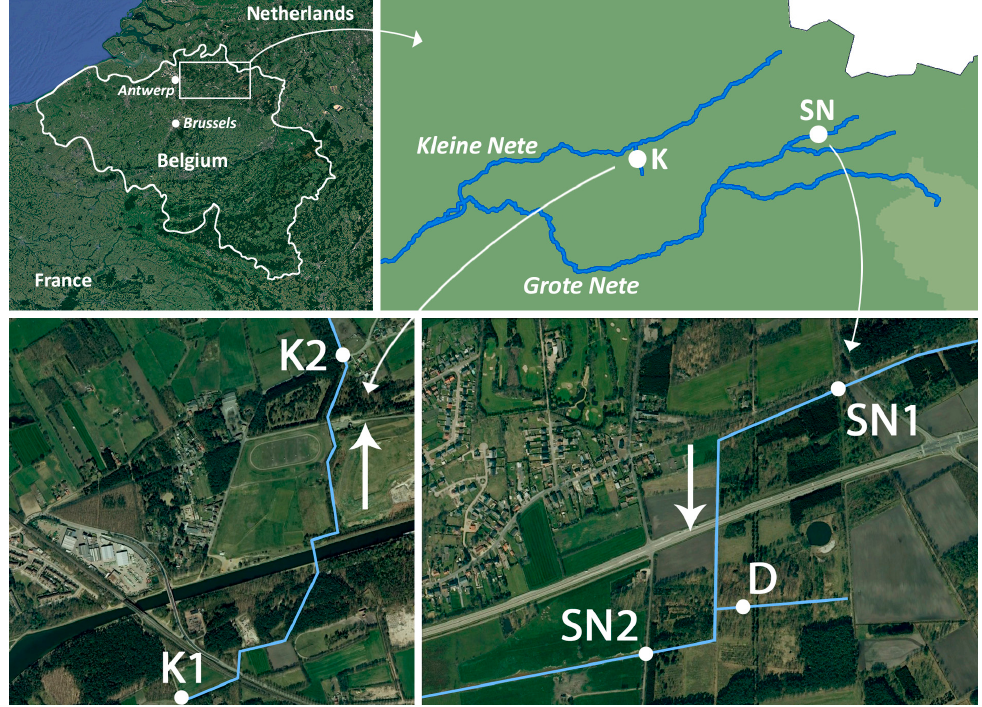
Figure 5. Map of the sampling sites. The Scheppelijke Nete is indicated as SN, the ditch as D and the Kneutersloop as K. The arrows indicate the direction of the flow. Kneutersloop as K. The arrows indicate the direction of the